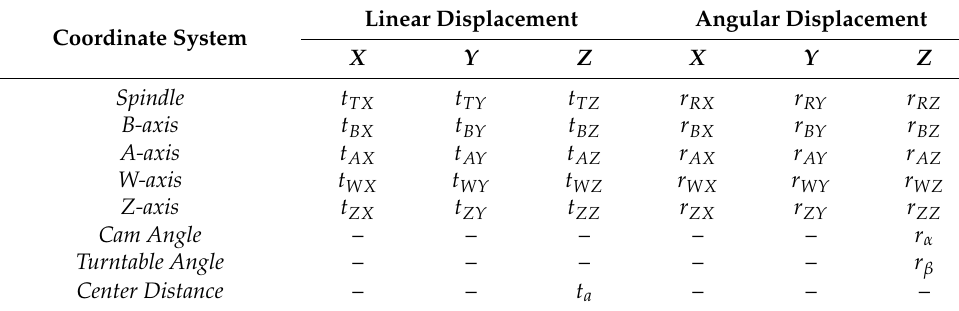
Table 2. Representation method of the transformation